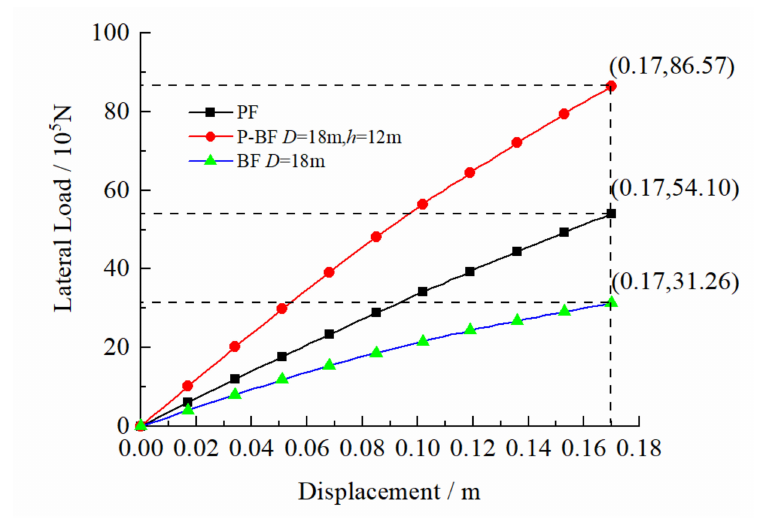
Figure 6. Comparison of the bearing capacity.